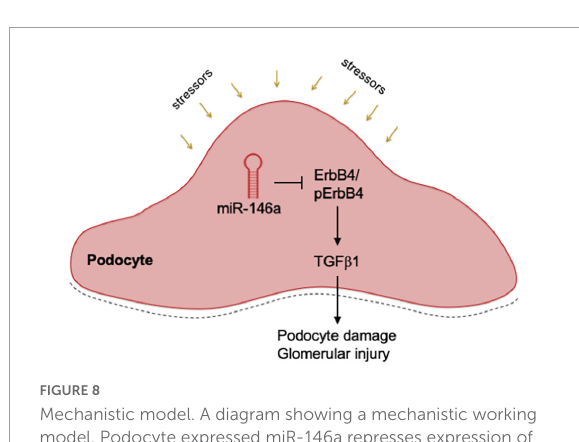
FIGURE8 Mechanistic model. A diagram showing a mechanistic working model. Podocyte expressed miR-146a represses expression of ErbB4 and Notch-1 during homeostatic conditions, thereby controlling the ErbB4/EGFR and TGF β 1 signaling pathways. Various external stressors or deletion of miR-146a result in de-repression of ErbB4 and Notch-1, thereby driving the harmful ErbB4/EGFR signaling and inducing TGF β 1. An autocrine feed-forward loop via TGF β 1 induces the downstream TGFR/Smad3 signaling, that result in podocyte damage, glomerular injury and